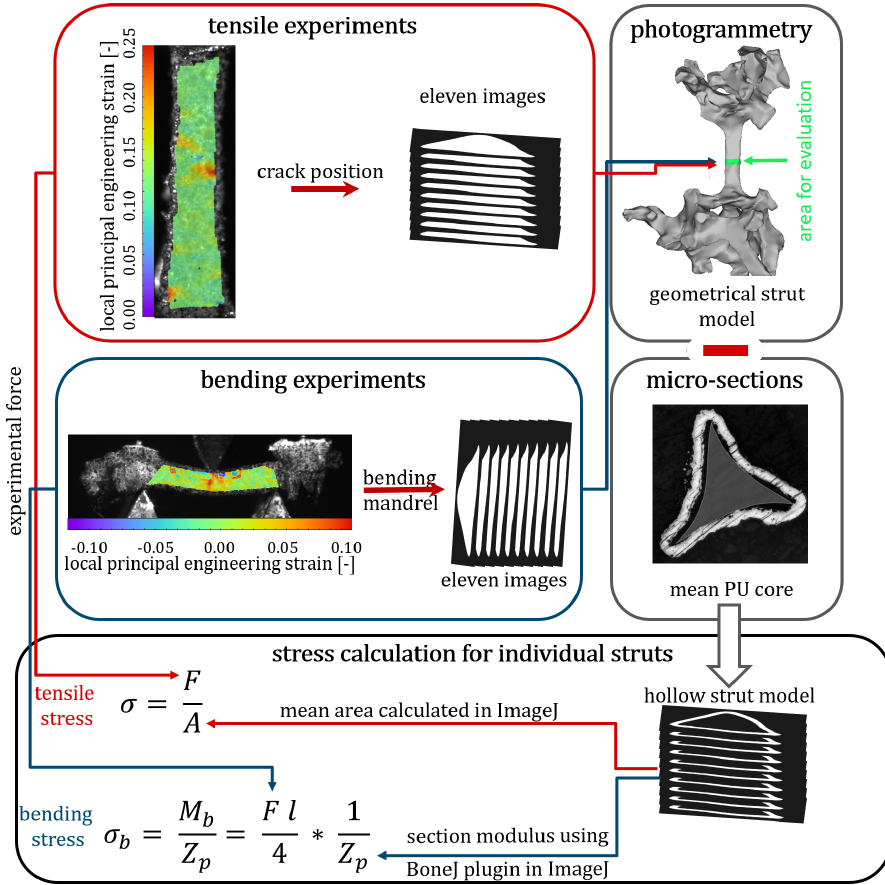
Figure 4. Overview of evaluation steps for stress calculation in individual Ni/PU hybrid foam struts during microtensile and microbending